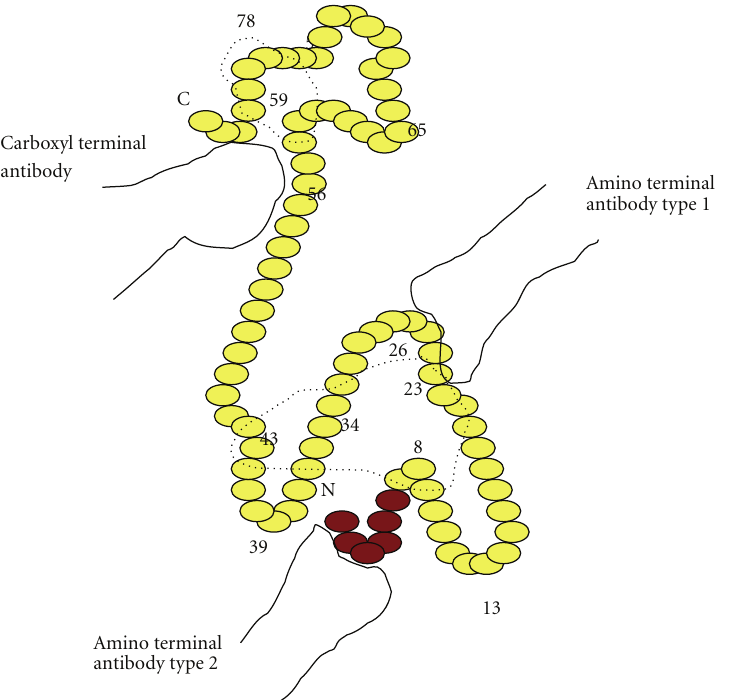
Figure 2: Schematic presentation of the regions of the PTH molecule recognized by the antibodies used in the immunometric assay design. Amino terminal antibody type 1 represents the most common antibodies employed for amino terminal sequence recognition. Amino terminal antibody type 2 refers to antibodies directed to the first amino acids of PTH